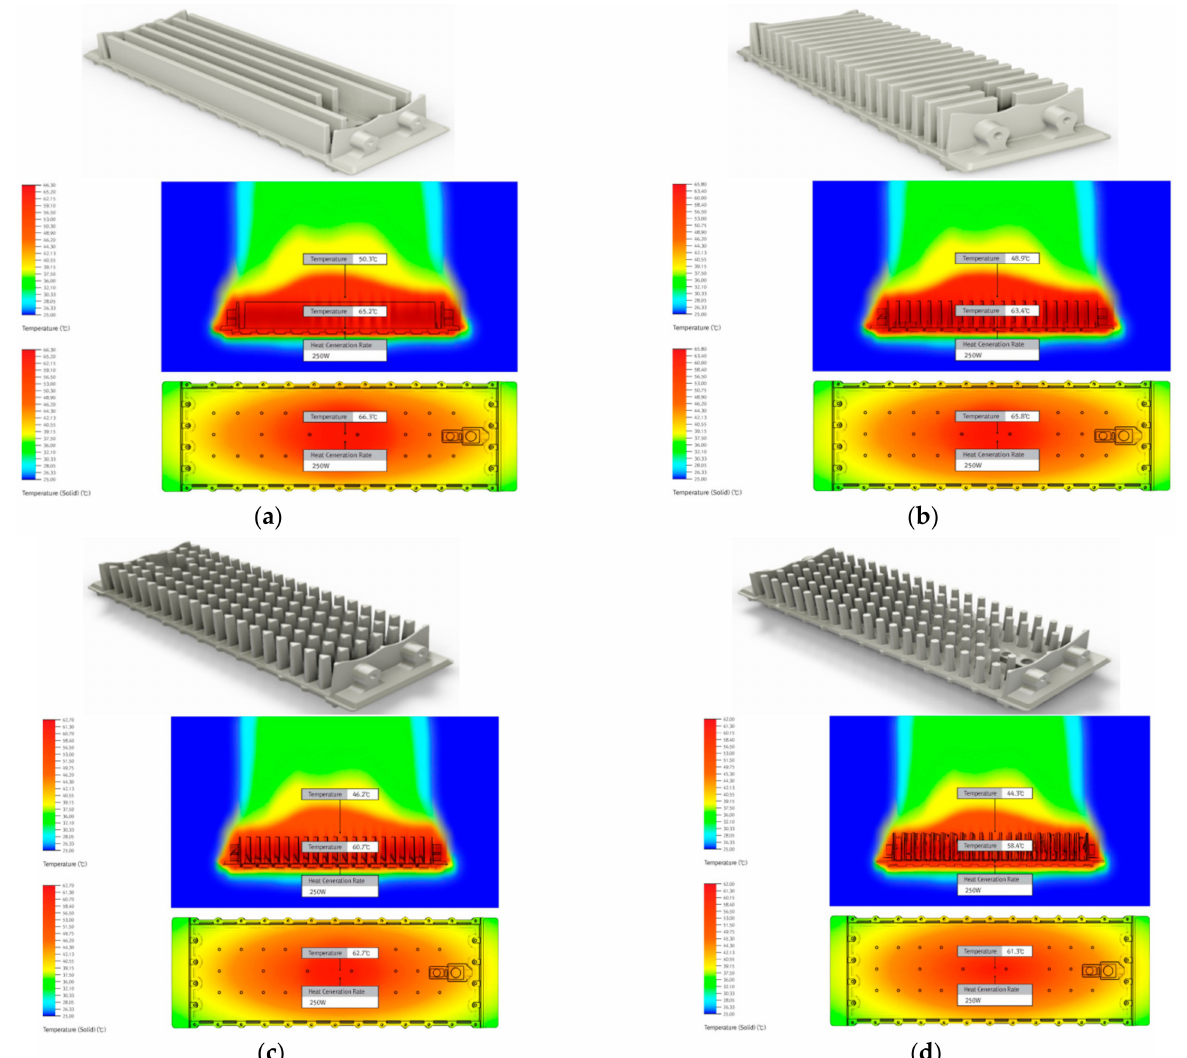
Figure 4. Heatsink design and thermal analysis result of type A with vertical fin ( a ), type B with horizontal fin ( b ), type C with triangle fin ( c ), and type D with hexagonal fin ( d ).